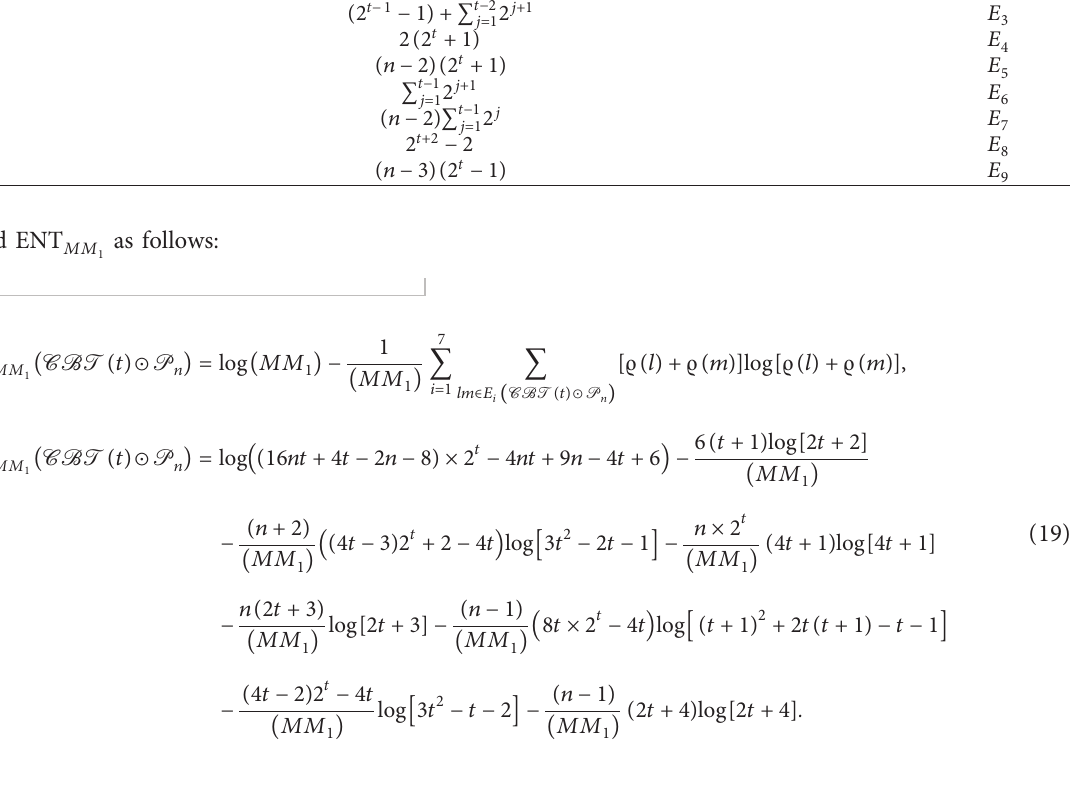
Table 6: Edge partition of CBT ( t ) ⊙ P